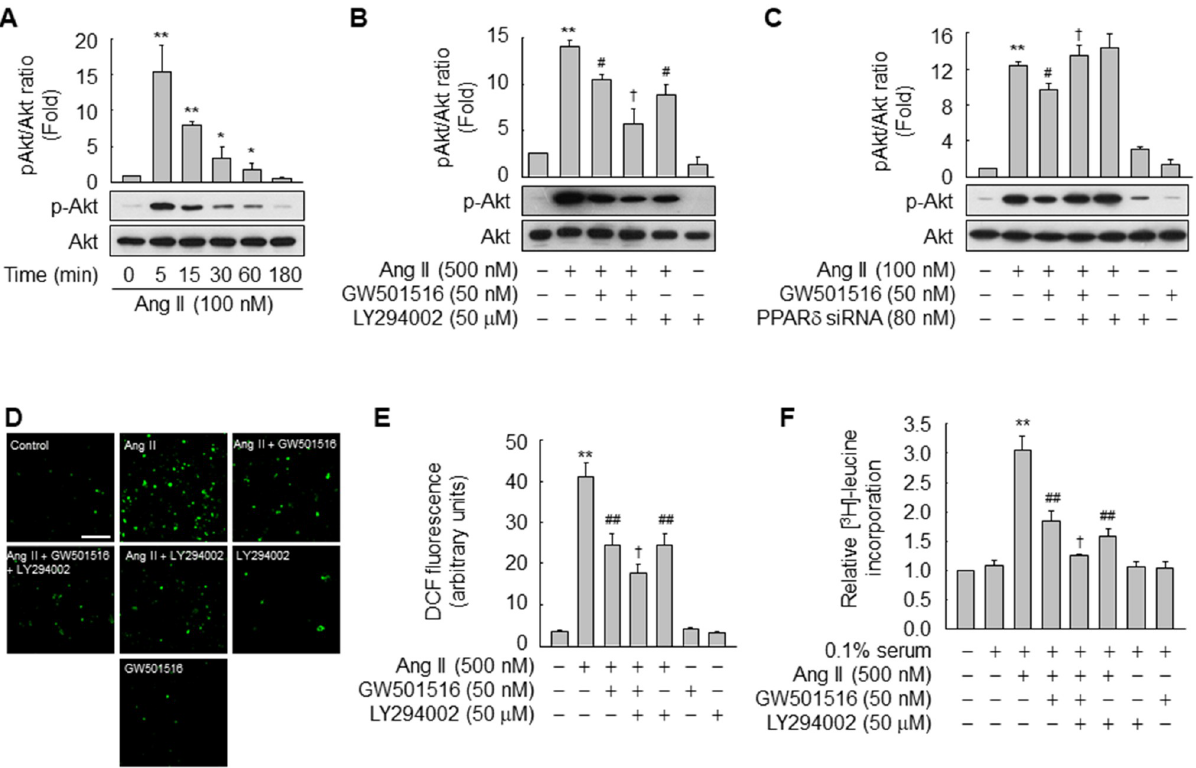
Fig 4. GW501516-activated PPAR δ suppresses Ang II-induced ROS generation and [ 3 H]-leucine incorporation in a PI3K/Akt-dependent manner. (A) VSMCs were treated with Ang II for the indicated durations. (B and C) VSMCs pretreated with LY294002 for 30 min (B) or transfected with PPAR δ -targeting siRNA for 48 h (C) were incubated in the presence or absence of GW501516 for 24 h and then exposed to Ang II for 24 h. Levels of phosphorylated and total Akt were determined by western blotting. Representative blots from three independent experiments and densitometric measurements are shown. (D and E) VSMCs pretreated with LY294002 for 30 min were incubated in the presence or absence of GW501516 for 24 h and then exposed to Ang II for 24 h. Intracellular ROS were detected by confocal laser fluorescence microscopy using CM-H 2 DCF-DA (D), and the fluorescence intensity was quantified (E). Bars, 200 μ m. (F) VSMCs pretreated with LY294002 for 30 min were incubated in the presence or absence of GW501516 for 24 h in DMEM containing 0.1% FBS. Thereafter, cells were exposed to Ang II for 24 h and pulsed with 1 μ Ci/mL [ 3 H]-leucine for the final 6 h. Data represent means ± SE (n = 3 or 4). �� p < 0.01, � p < 0.05 compared with the untreated group; ## p < 0.01, # p < 0.05 compared with the Ang II- treated group; and † p < 0.05 compared with the Ang II plus GW501516-treated group.